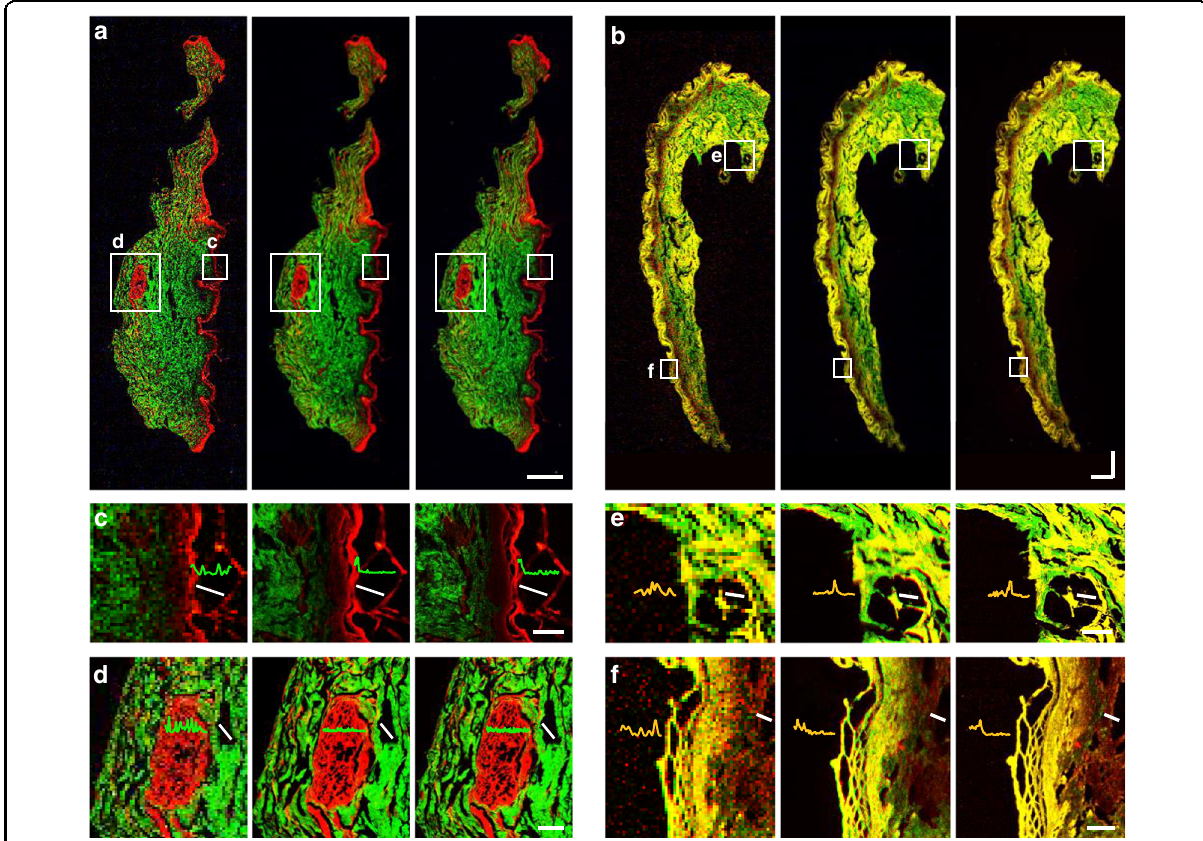
Fig. 4 Label-free multimodal nonlinear images of human skin. Large- fi eld images of normal skin tissue ( a ) and pigmented nevus tissue ( b ) with ROIs (white squares) magni fi ed in ( c ) – ( f ). From left to right: registered input, network output, and GT images. White solid lines in c – f refer to the line of the shown cross-section. Scale bars, 500 μ m in ( a ), ( b ), 50 μ m in ( c ), ( f ), and 100 μ m in ( d ), ( e